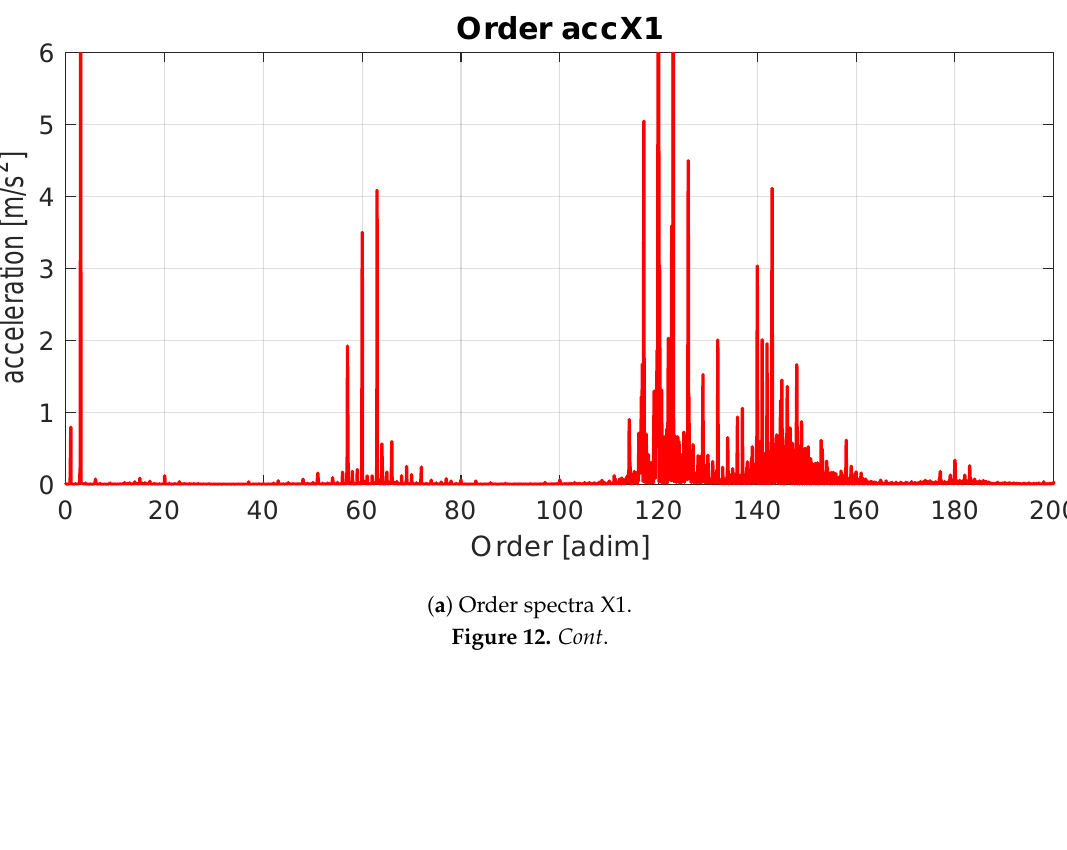
Figure 11. Waterplot of accelerations in y direction on layer 2.